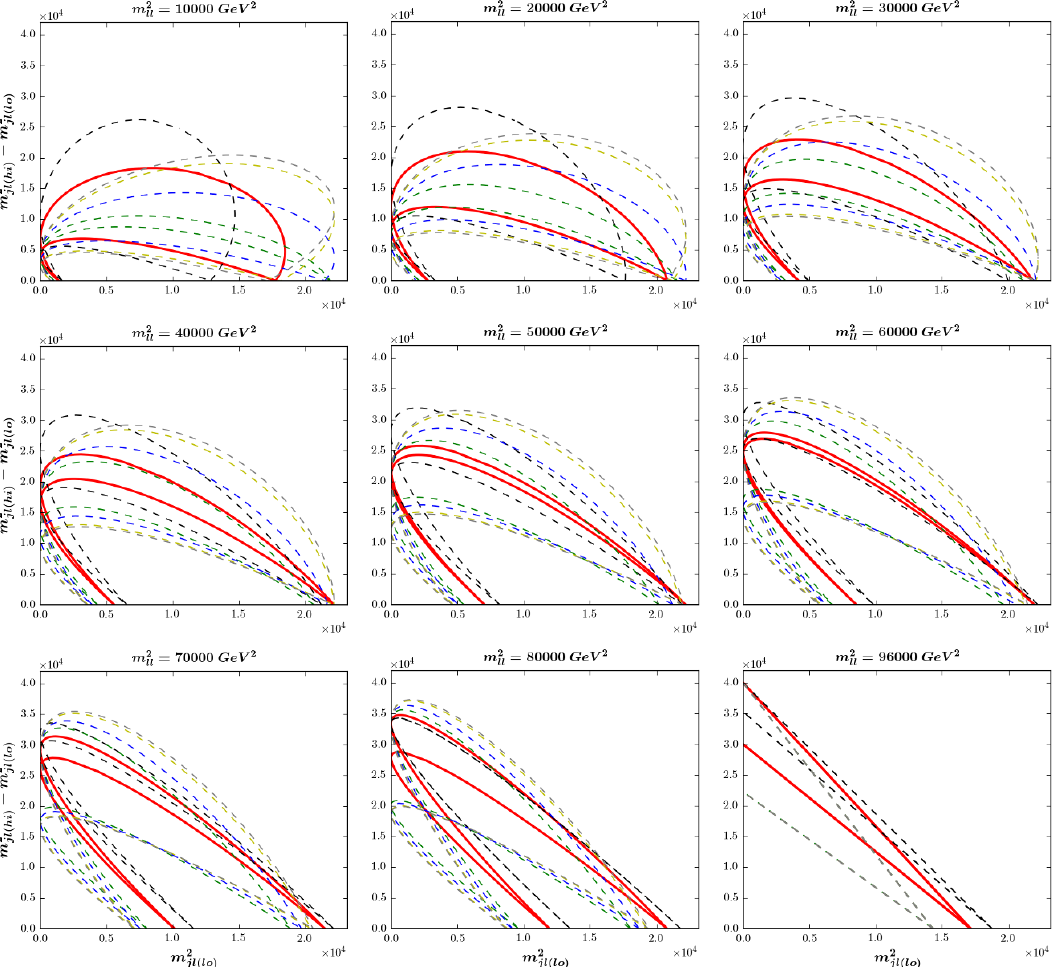
Figure 21 . The same as (cid:12)gure 9, but for the true branch in (cid:12)gure 15. The red solid line represents the case of the P 32 study point with ~ m A = 126 : 5 GeV, while the dashed lines correspond to other values of ~ m A along the true branch: ~ m A = 100 (black), ~ m A = 173 GeV (green), ~ m A = 500 GeV (blue), ~ m A = 2000 GeV (yellow) and ~ m A = 4000 GeV